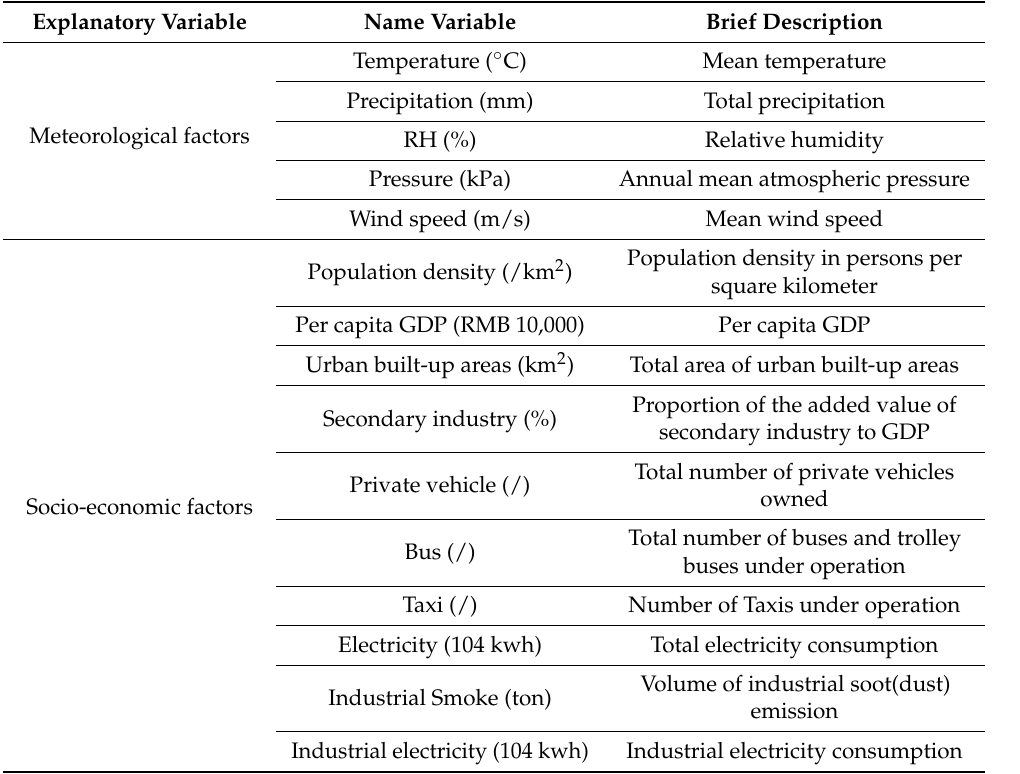
Table 1. Natural and socio-economic factors for airborne pollutants during